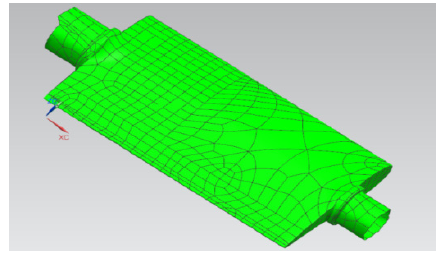
Figure 2. Guide vane surface